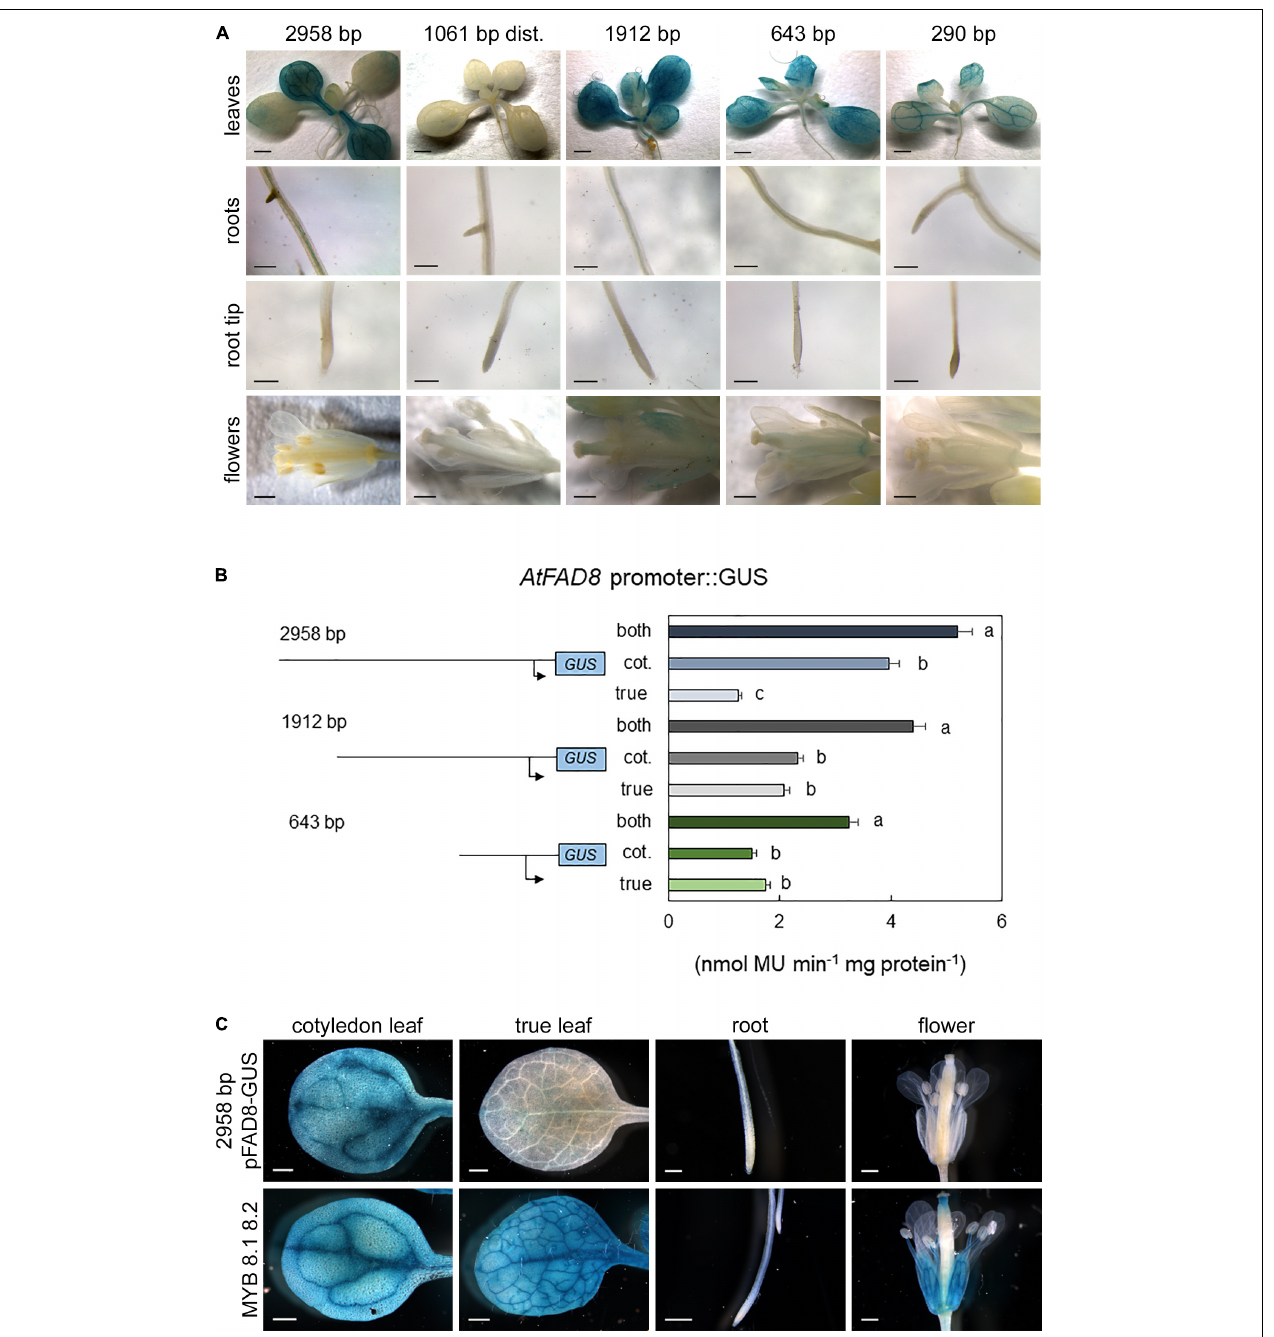
FIGURE 3 | GUS histochemical localization of the AtFAD8 gene promoter. (A) AtFAD8 promoter:GUS staining in leaves, roots and flowers. Results are shown for the control AtFAD8 2,958 bp fragment and the four deletions of 1,061 bp, 1,912 bp, 643 bp and 290 bp, respectively. Results were obtained after 3 h of GUS staining. Images are representative of at least three independent transgenic lines. Scale bars represent: 1,000 µ m in plantlets, 200 µ m in roots and 500 µ m in flowers. (B) GUS activity in the AtFAD8 gene promoter fragments. Activity was determined in extracts from the aerial part of 2-week old plants carrying the different AtFAD8 promoter fragments. Activity was determined separately in cotyledonal and true leaves. Results were obtained after 3 h of GUS staining. A schematic diagram of the different promoter length fragments used for the analysis is also shown. Activity was determined as nmol MU · min - 1 · mg protein - 1 . Data are means ± SE from at least five independent determinations of three independent transgenic plants. Different letters indicate significant differences among treatments ( P < 0.05). (C) AtFAD8 promoter:GUS staining in leaves, roots and flowers in transgenic lines in which the two MYB putative target sequences detected in the distal region of the AtFAD8 gene 2,958 bp promoter fragment were modified by site-directed mutagenesis. Lines containing the 2,958 bp AtFAD8 fragment were used as a control in all tissues. Results were obtained after3 h of GUS staining. MYB 8.1 8.2 represents the lines carrying the site-directed mutation on the MYB target sequences. Images are representative of at least three independent transgenic lines. Scale bars represent: 500 µ m in leaves and flowers, 200 µ m in roots.